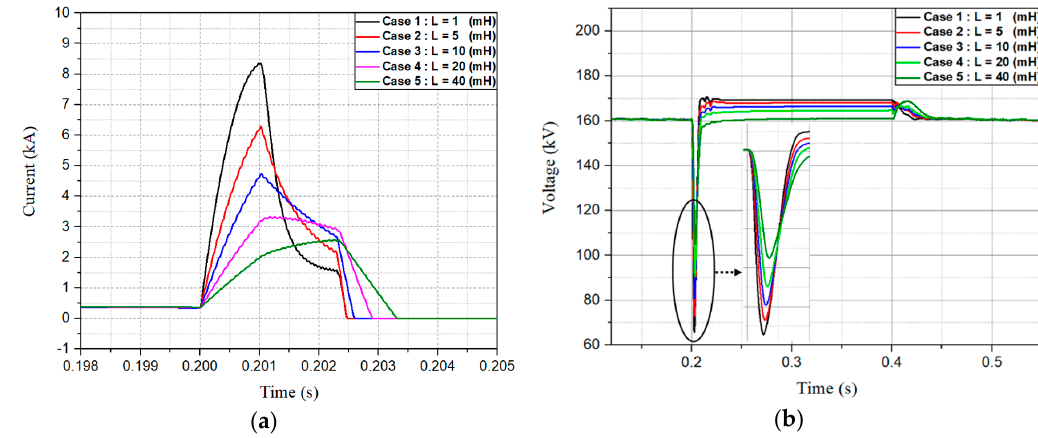
Figure 11. The DC current and voltage waveform in transient state: ( a ) current waveform; ( b ) voltage waveform measured at converter terminals.